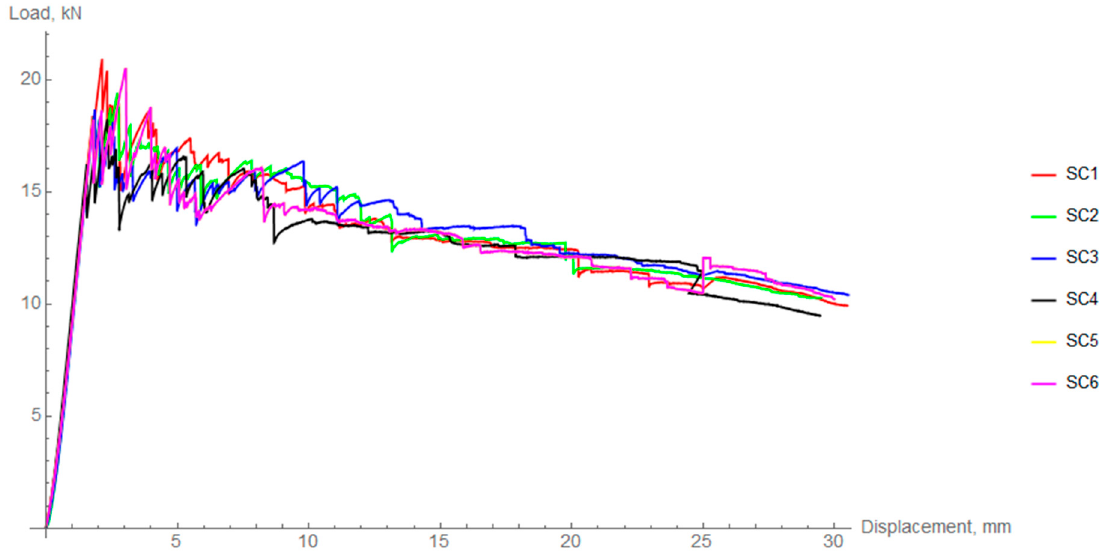
Figure 11. Load-displacement curves for radial compression of slow cooled (SC) rings.